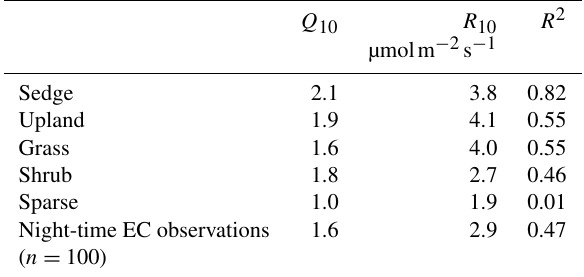
Table 3. The ER temperature sensitivity ( Q 10 ) and base respiration ( R 10 ) estimated by Laforce (2018) and estimated from nighttime EC footprint observations. Q 10 R